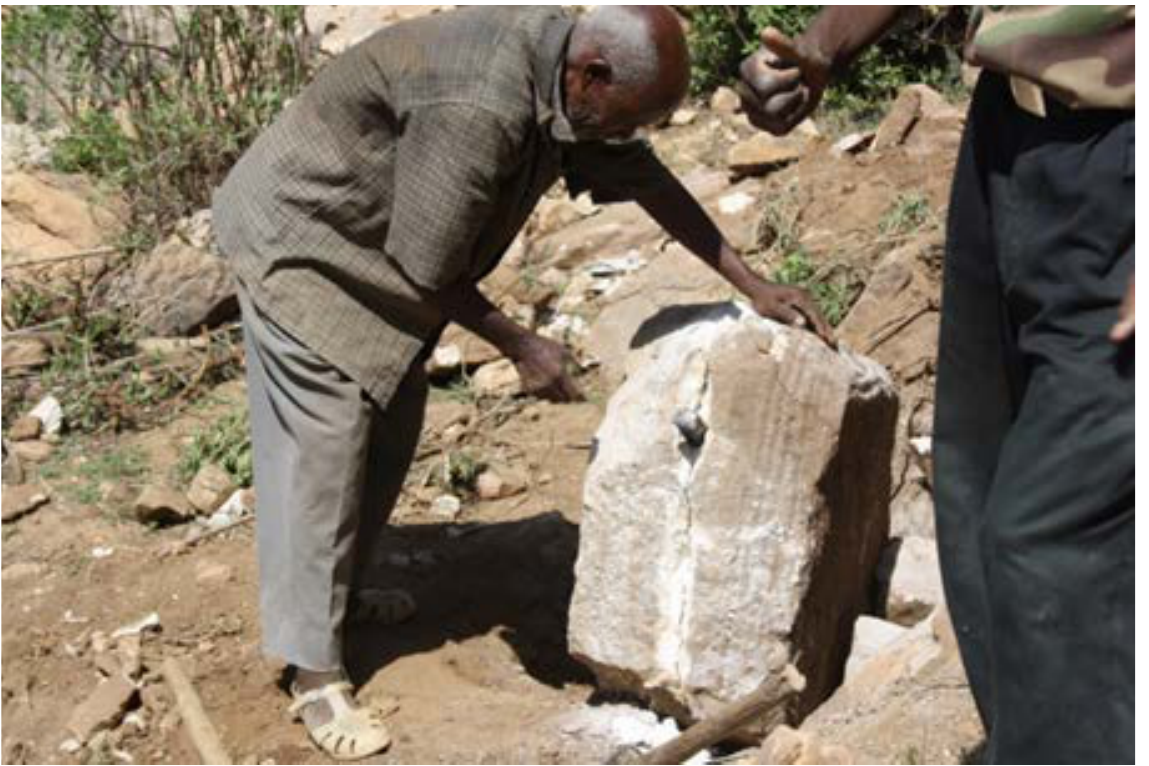
Figure 8. Haleka Tehwoelde Brahn Beyene (expert) using wedges and a sledge hammer to ‘break’ the boulder in